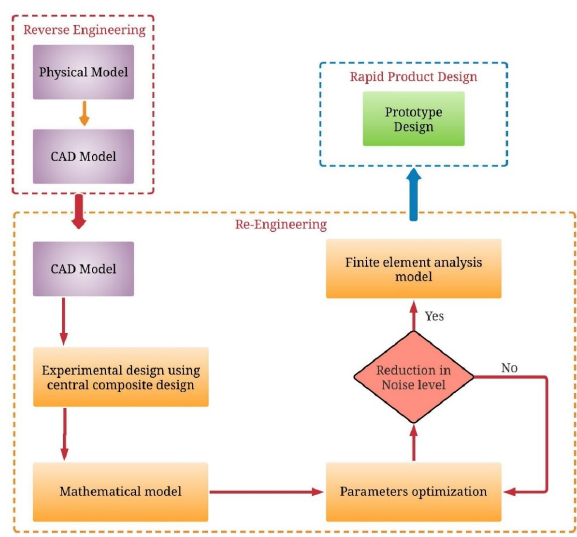
Figure 1: Integrated working flow of low noise blade